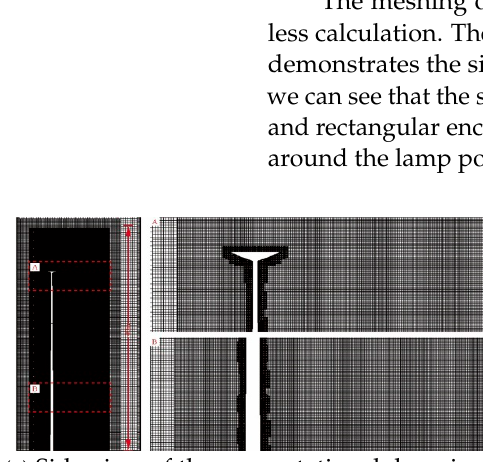
( b ) Side view Figure 7. Schematic diagram of the calculation domain size and boundary conditions. Inlet boundary conditions (inlet): The left-hand side boundary along the wind di- rection is set as the velocity inlet boundary condition, and the UDF custom function is used to define the average wind profile to take into account the variation in windspeed along the height direction. Outlet boundary condition (outlet): The pressure value is at-